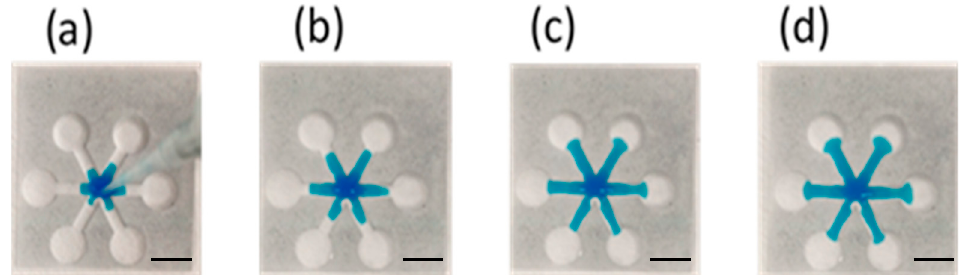
Figure 7. The sequential images of ink wicking through the channels at ( a ) 1, ( b ), 4, ( c ) 8 and ( d ) 12 s. Scale bar: 4 mm. Polymers 2020 , 12 , x FOR PEER REVIEW 7 of 10